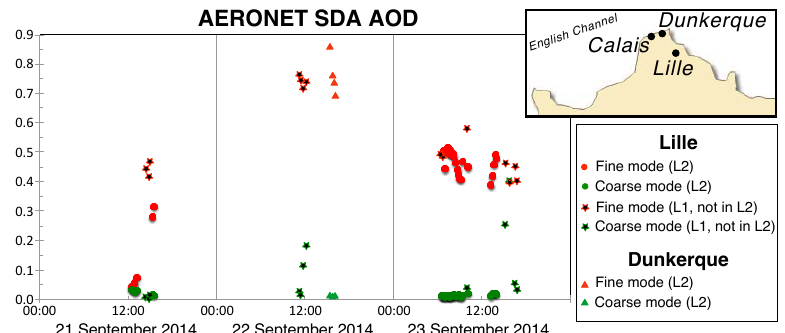
Figure 3. AERONET sunphotometric fine and coarse mode aerosol optical depth (AOD) at 500nm retrieved using SDA algorithm in Lille and Dunkerque from 21 to 23 September 2014. Map of northern France in